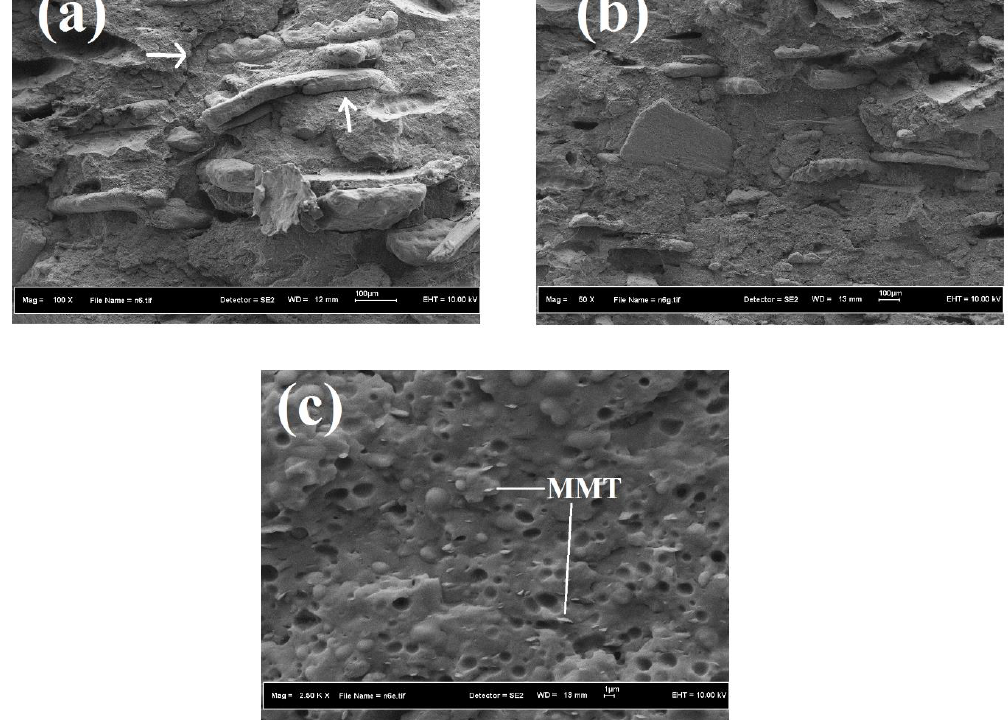
Figure 3. SEM micrographs of cryofractured surfaces of ( a ) PR, ( b ) PRC, and ( c ) PRMC.